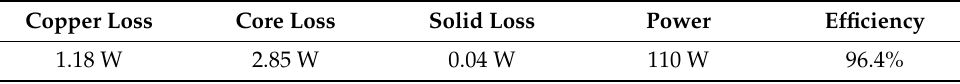
Figure 10. Core loss analysis result according to driving frequency. Table 1. LOM losses and efficiency @ rated load.